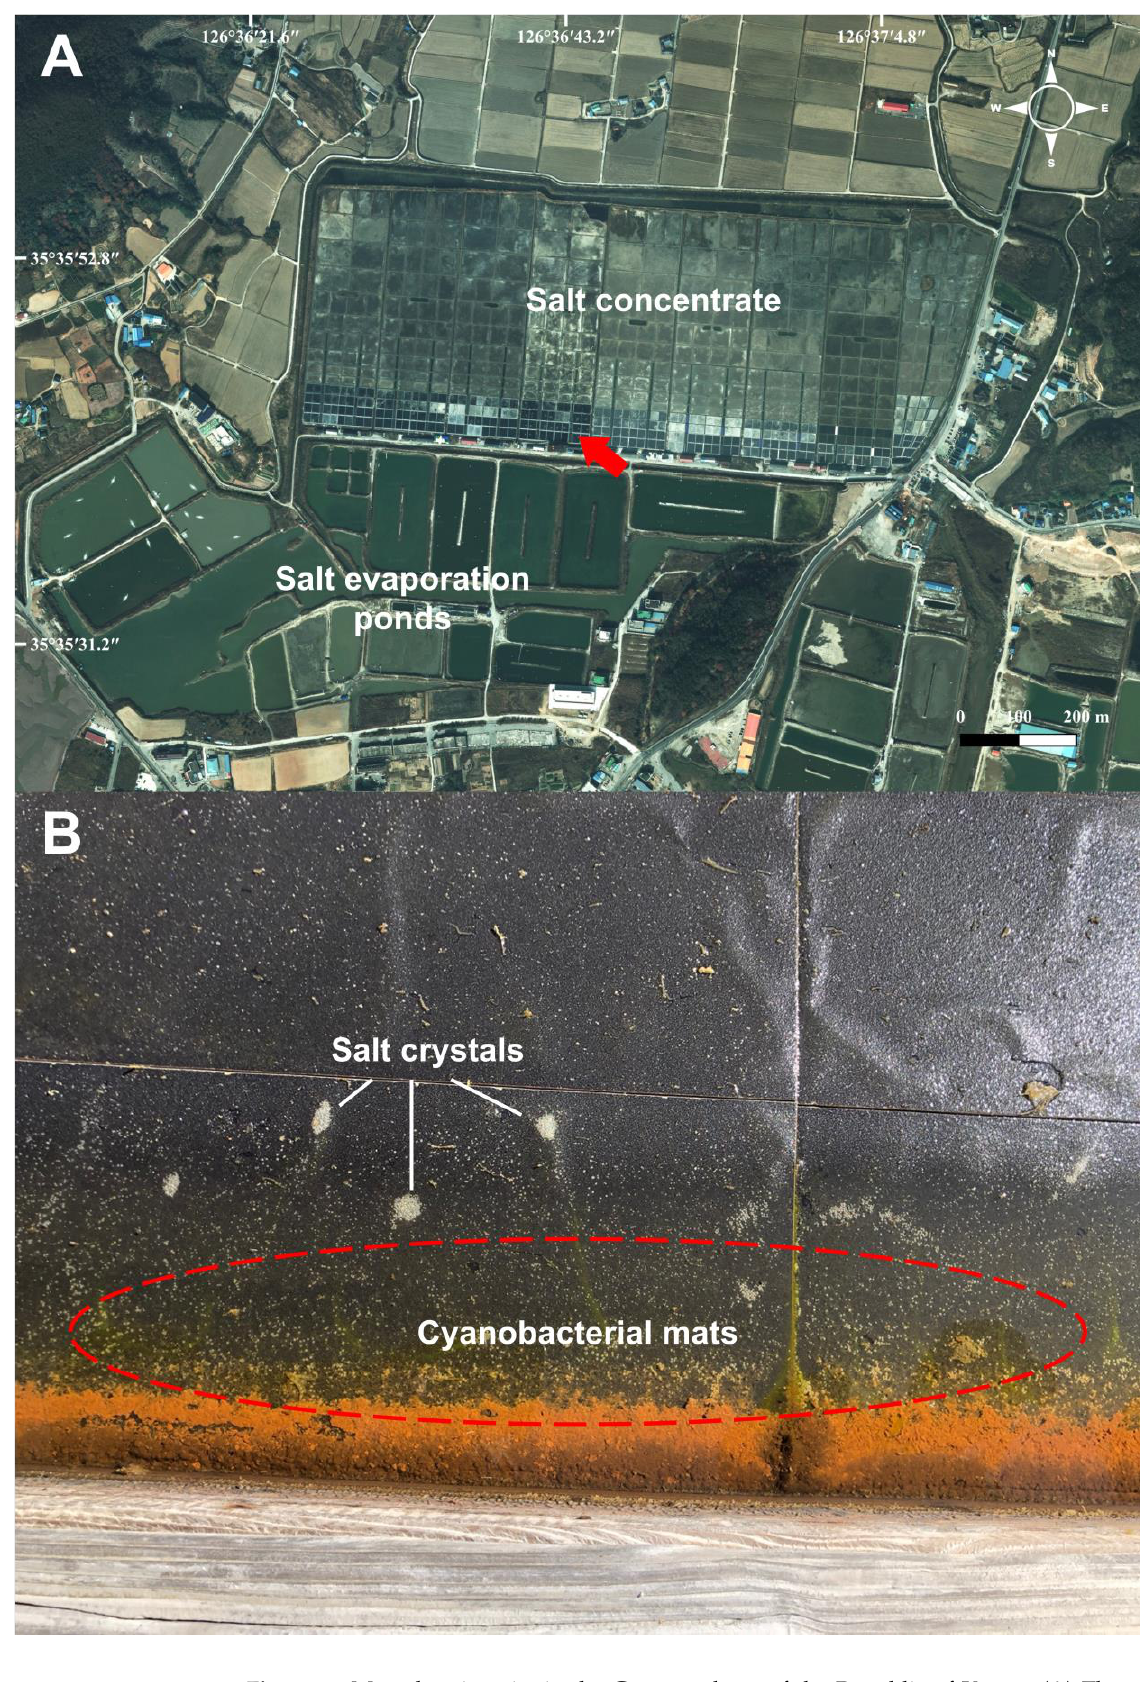
Figure 1. Map showing site in the Gomso saltern of the Republic of Korea. ( A ) The red arrow indicates a sample site; ( B ) Collections from the substrate of black tile in cyanobacterial mats (red circle) (in saline, >50).